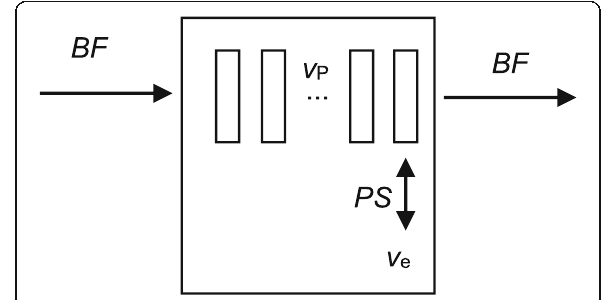
Fig. 3 Schematic of the AATH model used to analyze the perfusion CT data: BF is the blood flow through the tumor, v P the intravascular plasma volume fraction, v e the extracellular extravascular space, and PS the permeability surface area product which defines the exchange rate between plasma and the extravascular extracellular space